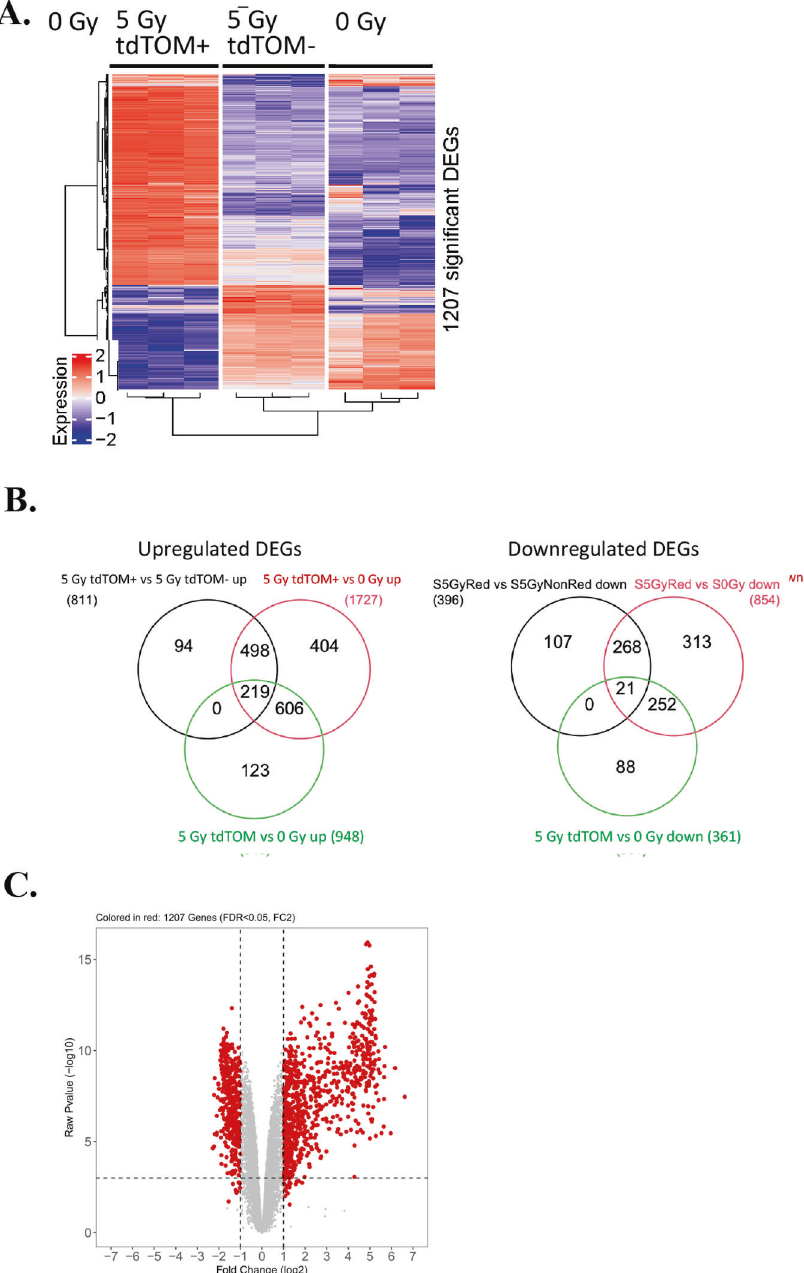
Fig. 2 Irradiation-induced tdTOMp16 + senescent cells display a unique transcriptome compared to non-irradiated, or irradiated, but non-senescent cells. A The RNA-seq heat map illustrates the expression level of the DEGs between groups. Each row represents a gene and of the nine columns, from left to right, the fi rst three are irradiated senescent (tdTOM + ) samples, the next three columns in the middle are irradiated non-senescent (tdTOM-) samples, and the three columns on the right are non-irradiated samples. The value is the z- score of normalized gene expression counts. For any given gene, the red color represents gene expression that is greater than the overall mean, and the blue color represents gene expression that is less than the overall mean. Hierarchical clustering of genes and samples are represented by the dendrograms on the left and across the bottom of the heat map. B Venn diagram depicting the shared and unique distribution of the DEGs. On the left are upregulated genes with comparisons between all three groups and on the right are comparisons with downregulated genes. Genes comparing irradiated senescent & irradiated non-senescent samples group are in black circle, irradiated senescent & non- irradiated samples are in red circle, and irradiated non-senescent & non-irradiated samples are in the green circle. C Volcano plots show the log2 (fold change) and − log10 (adjusted P value) of the genes comparing irradiated senescent and irradiated non-senescent cells from the RNA-seq dataset. The statistically signi fi cant DEGs are represented in red. The statistical criteria for a gene to be considered differentially expressed was a fold change ≥ 2 and an adjusted P value ≤